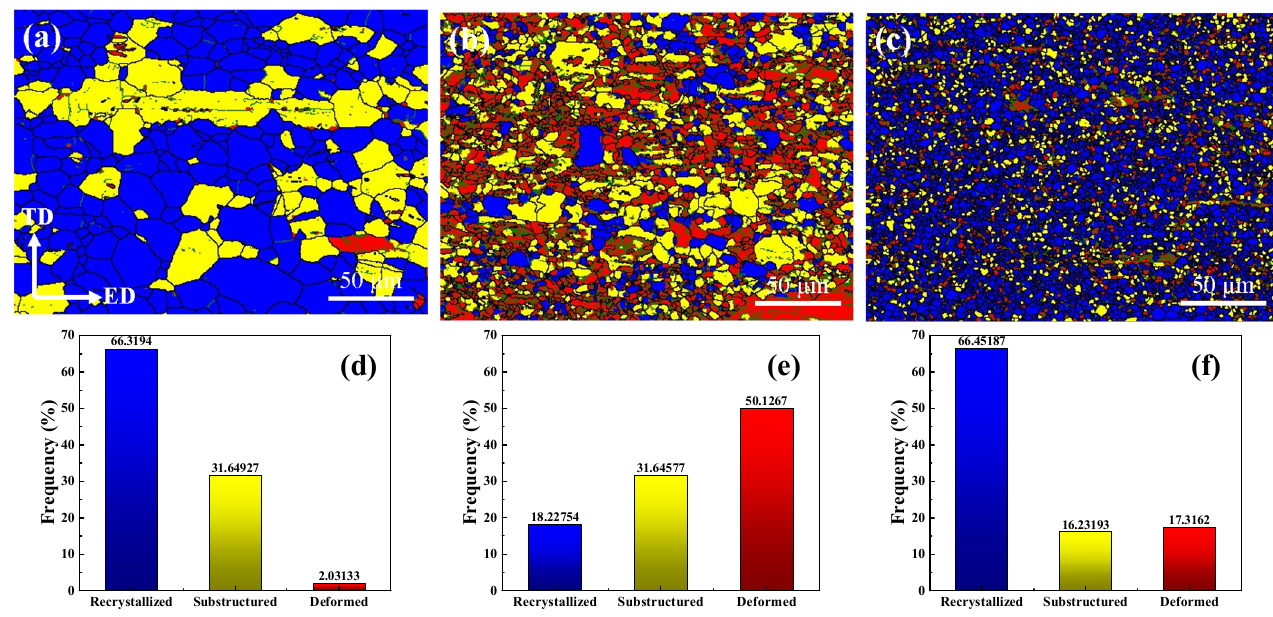
Figure 6. Different types of grain distribution: ( a , d ) T3, ( b , e ) TX31, ( c , f )